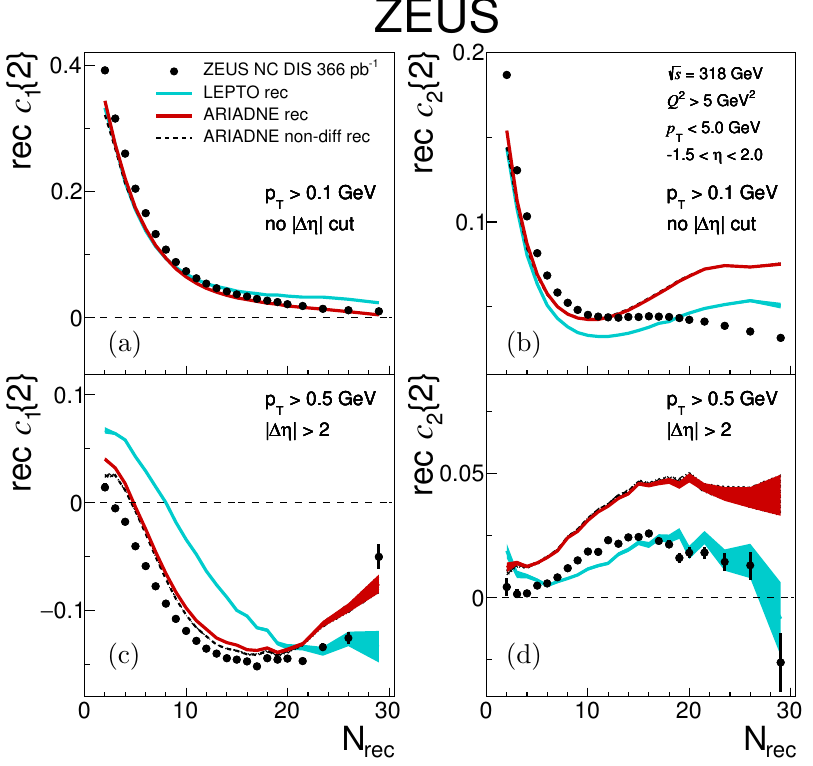
Figure 3 . Reconstructed c 1 f 2 g and c 2 f 2 g versus N rec . The (a) and (b) panels represent the kine- matic intervals given by p T > 0 : 1 GeV and no j (cid:1) (cid:17) j cut. The (c) and (d) panels are further constrained by p T > 0 : 5 GeV and j (cid:1) (cid:17) j > 2. The predictions from ARIADNE, ARIADNE non- di(cid:11)ractive, and LEPTO are shown. The ARIADNE non-di(cid:11)ractive prediction is often hidden by the band of the full ARIADNE prediction. Statistical uncertainties are shown with vertical lines for ZEUS data and with bands for the Monte Carlo